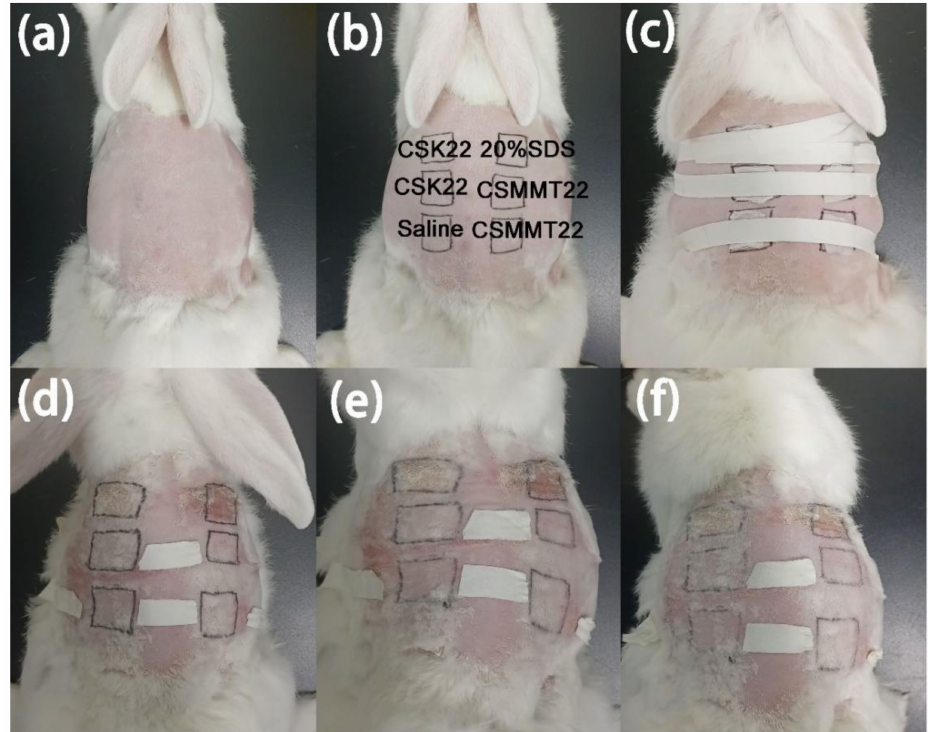
Figure 12. ( a ) Exposed skin, ( b ) experimental area for each sample, ( c ) medical tape fixation, ( d ) 24 h after patch removal, ( e ) 48 h after patch removal, ( f ) 72 h after patch